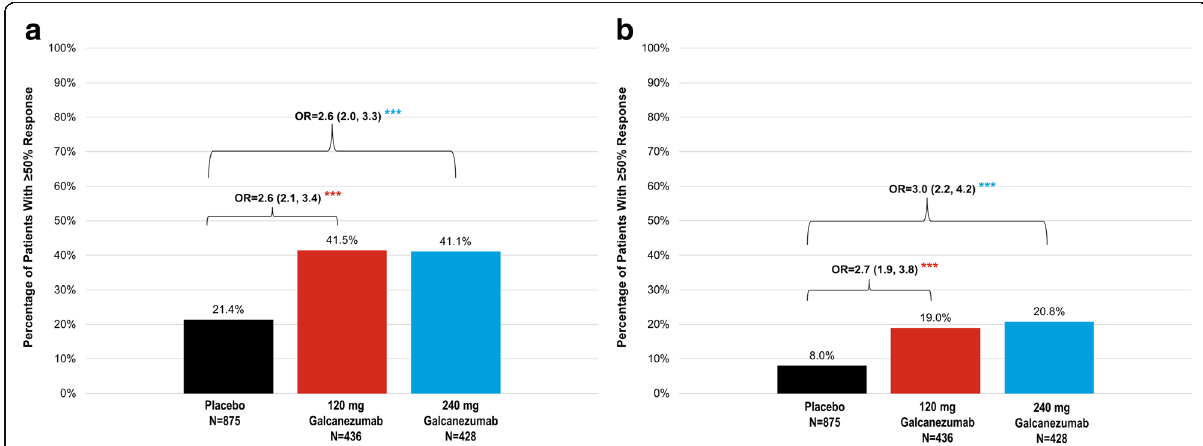
Fig. 1 Episodic migraine: proportions of patients with maintenance of ≥ 50% response for ≥ 3 consecutive months until patient ’ s endpoint and response from month 1 to month 6. a maintenance of ≥ 50% response for ≥ 3 consecutive months. b maintenance of ≥ 50% response from month 1 to month 6. Abbreviations: OR = odds ratio. *** = p < 0.001